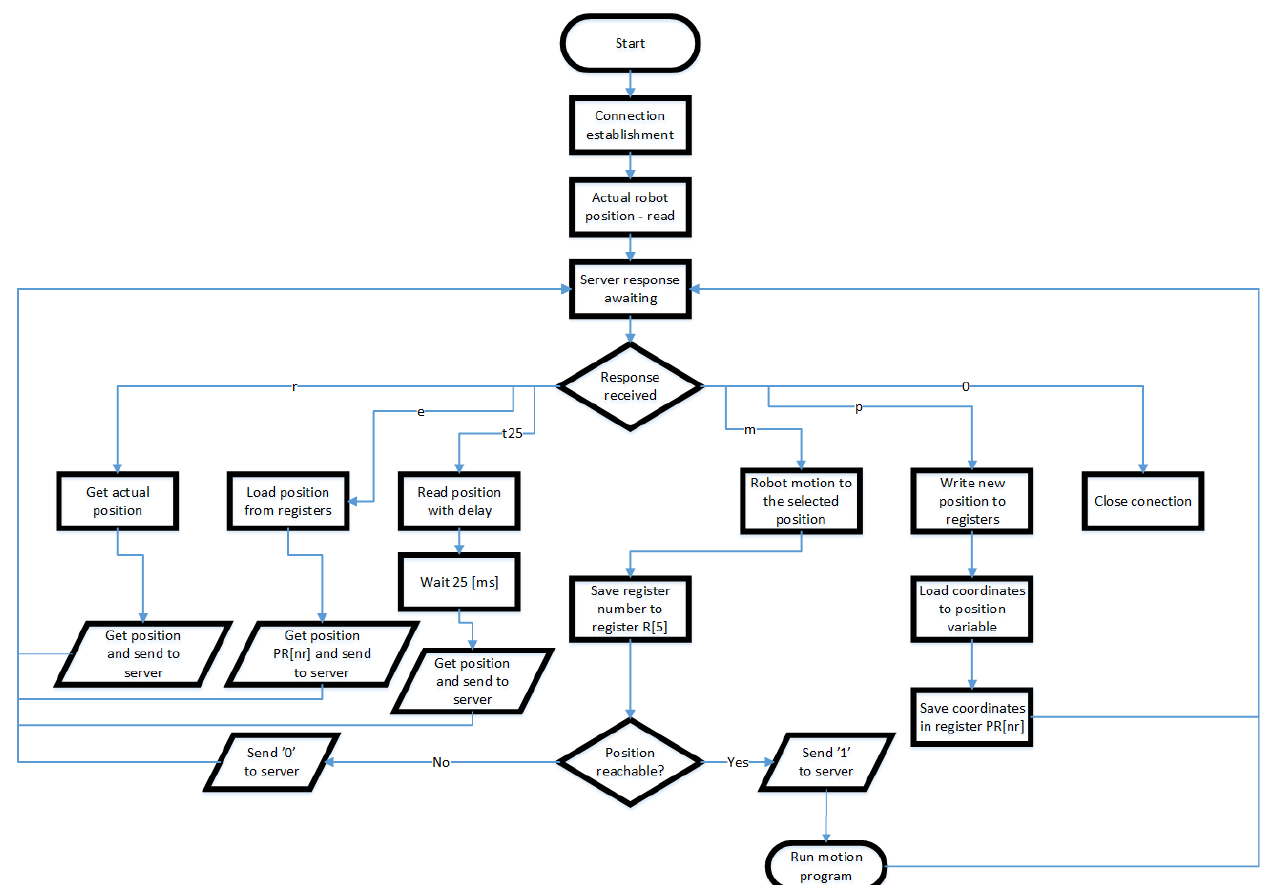
Figure 4. Server–client program activity